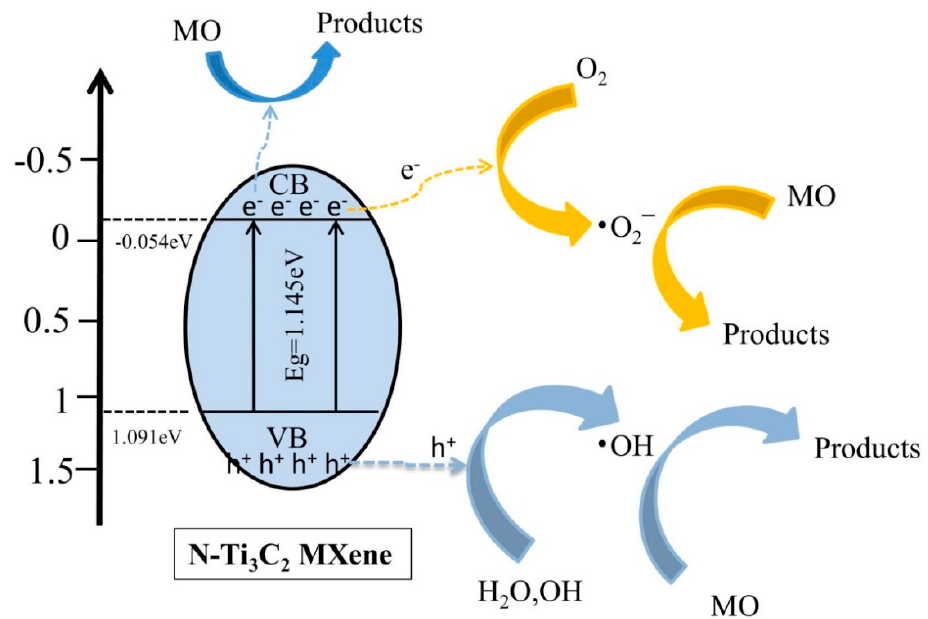
Figure 11. Photocatalytic degradation mechanism of N ‐ Ti 3 C 2 MXene.